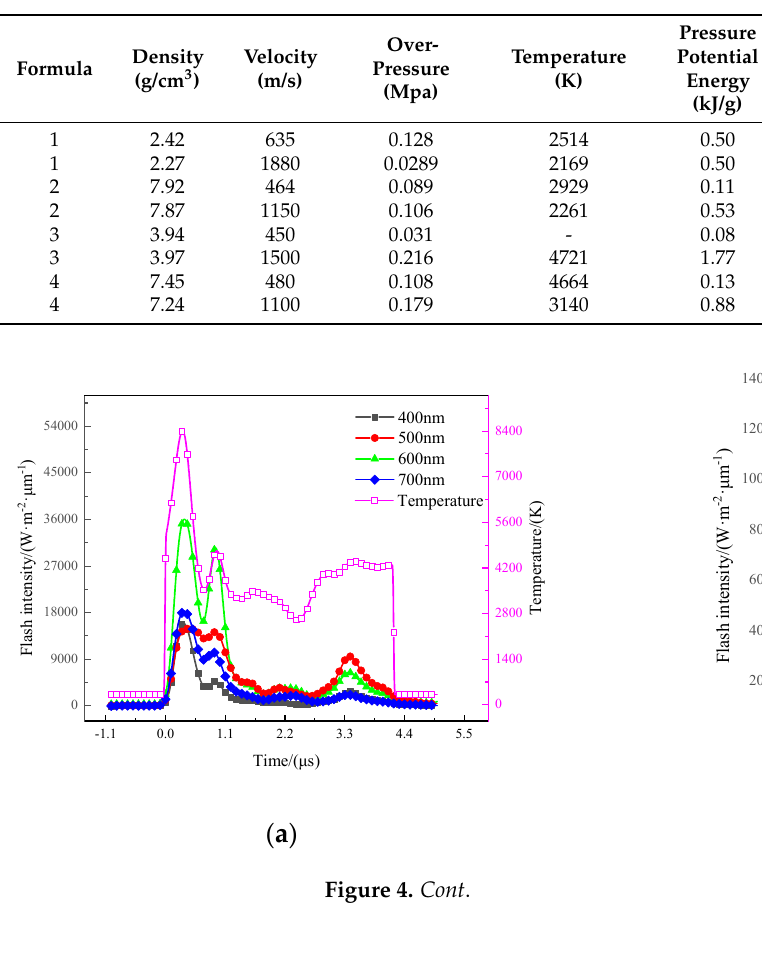
Table 4. The performance of energy release by RMs projectile.